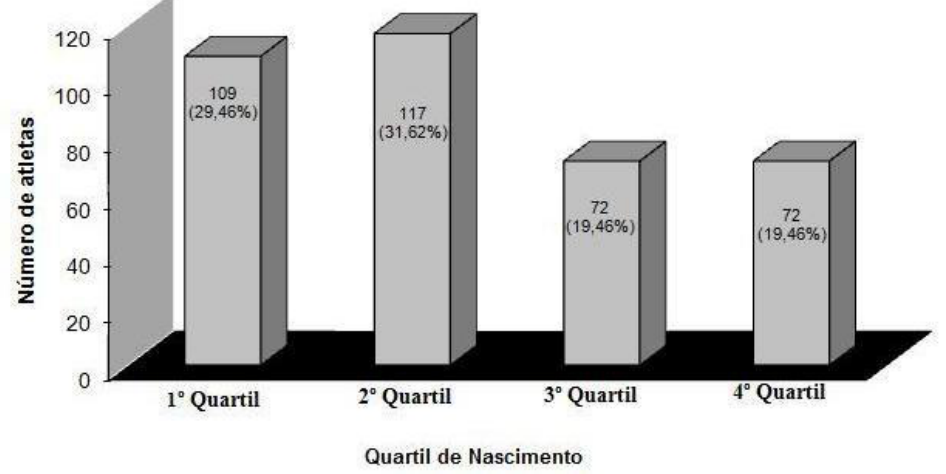
Figura 1. Distribuição dos Quartis de Nascimento dos atletas que disputam a Liga Futsal 2009. Na Tabela 1 são exibidos os valores do teste de Qui-Quadrado para a distribuição das datas de nascimento dos